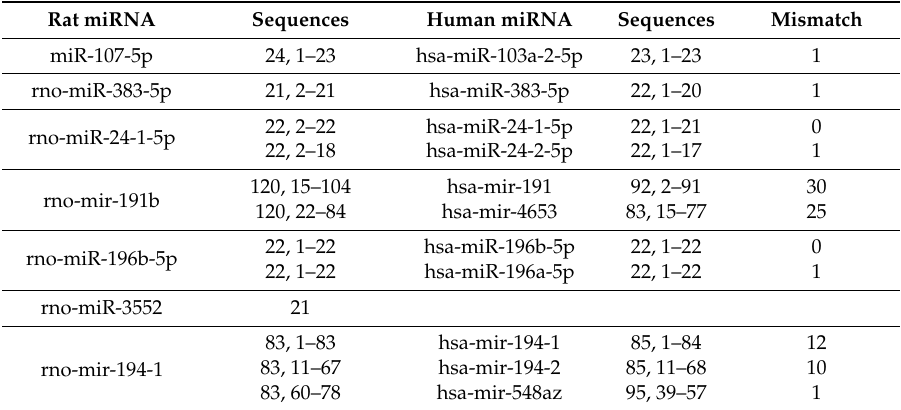
Table 5. Human miRNAs with sequences similar to significantly regulated miRNAs found in rat blood